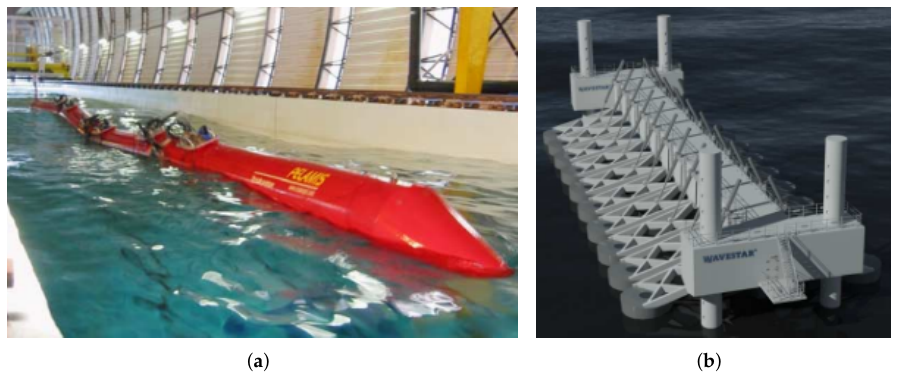
Figure 12. Typical articulated systems installed on different WECs. ( a ) Pelamis WEC [47]. ( b ) WaveS- tar WEC [168].